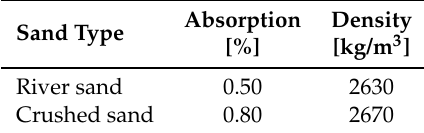
Table 3. Water absorption and density of sands.